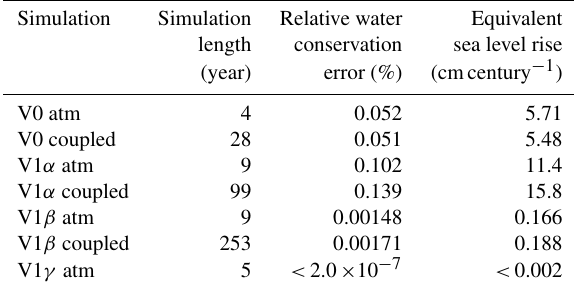
Table 1. Water conservation error from the atmosphere model com- ponent in the coupled and atmosphere-only (atm) simulations with E3SM V0, V1 α and V1 β . The relative errors are given as the ra- tio to the global mean precipitation rate, calculated using Eq. (5) in Sect. 4. The “artificial sea level rise” is defined as an equivalent sea level rise due to the artificial source of water substances in the at- mosphere model, calculated using Eq. (6) in Sect. 4. The results are slightly different if a different length (number of years) is chosen, but they are very similar to the numbers shown in the table.